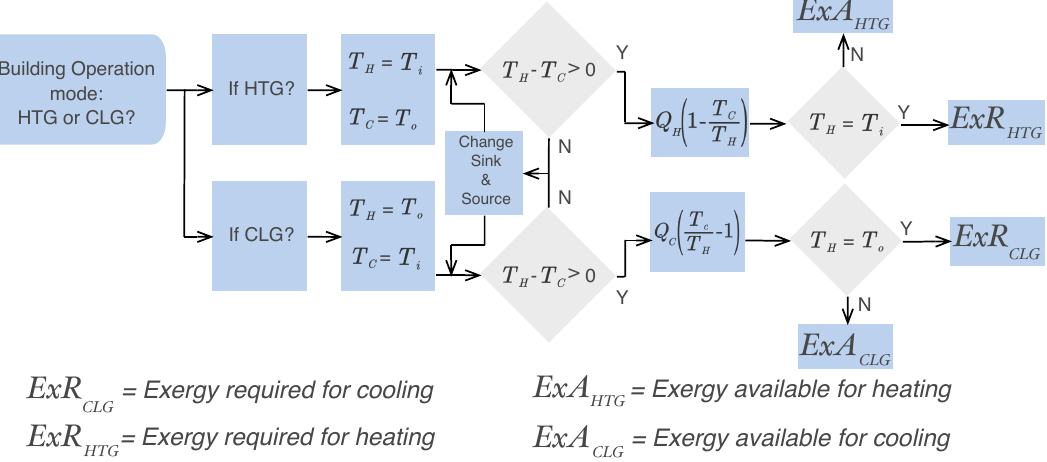
Figure 7. The script for computing different types of